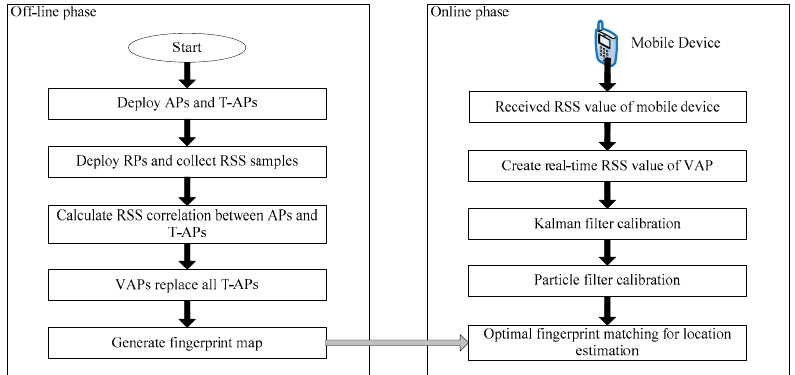
Figure 5. The workflow of the proposed positioning system algorithm mainly uses kernel function to change fingerprint samples into high-dimensional feature space, which makes the sample set with non-linear characteristics have linear separability. The process of optimal fingerprint matching includes feature extraction and feature vector matching. Compared with WKNN algorithm, KPCA algorithm has higher accuracy in fingerprint matching.